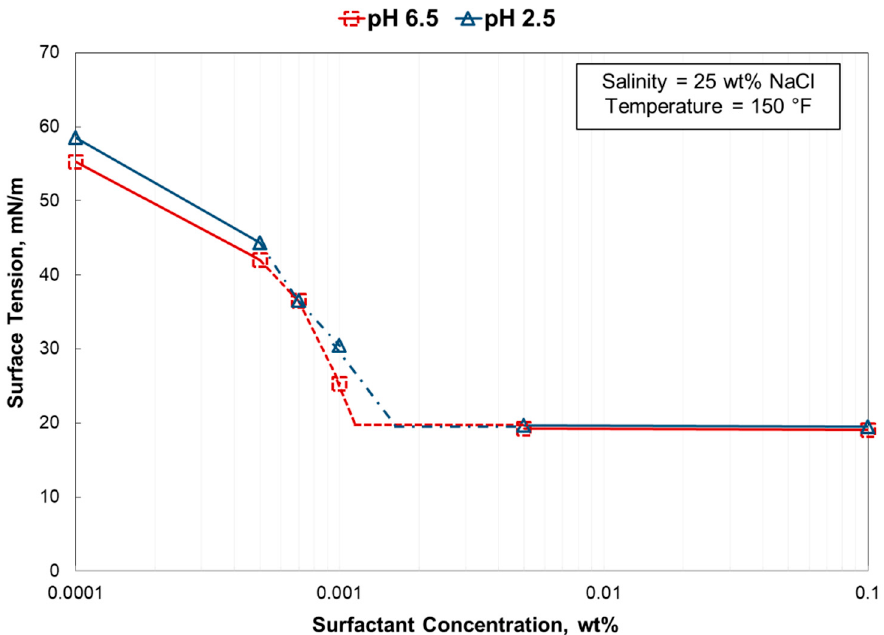
Figure 18. Effect of initial pH on surfactant solution interfacial properties at 25 wt% NaCl and 150 °F (65 °C).